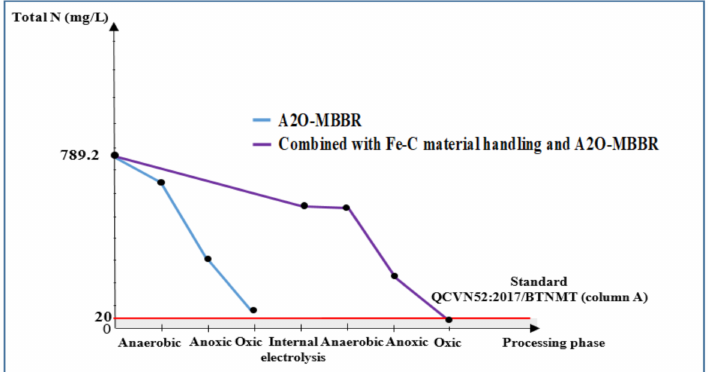
Figure 11. Total N treatment e ffi ciency (mg / L) through A2O-MBBR system and through treatment of Fe-C material combined with A2O-MBBR system.